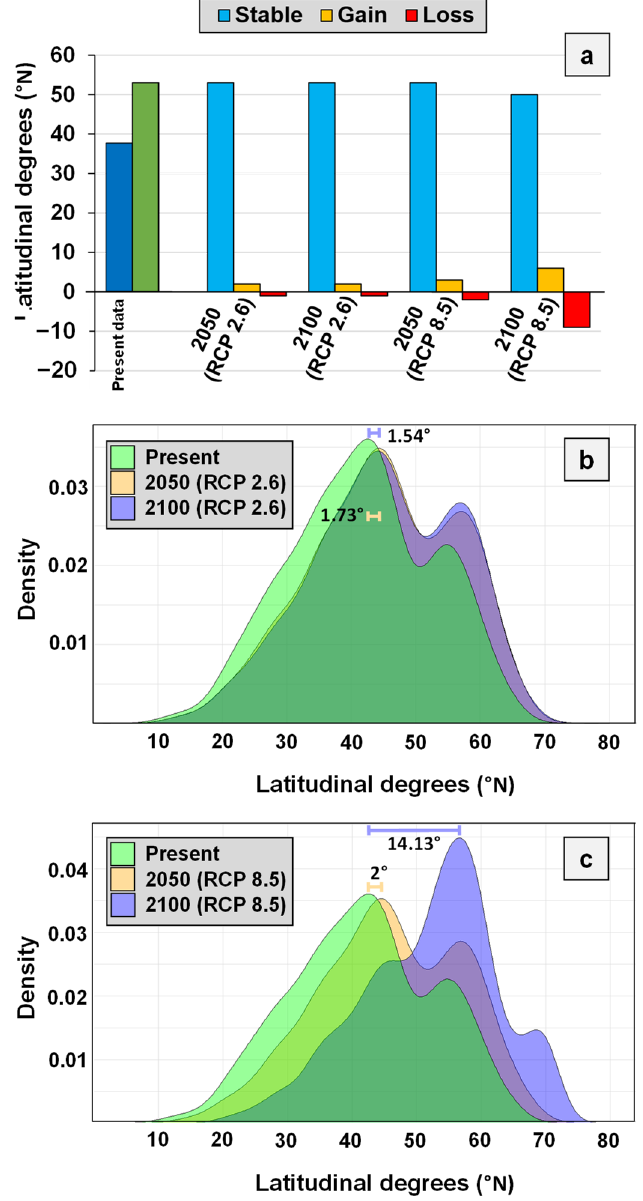
Figure 4. Panel ( a ): Current distribution (green bar), and variations in habitat suitability of Gracilaria vermiculophylla in the Northern Hemisphere under present conditions and under future climate change framework predicted for two carbon emission scenarios (RCP 2.6 and RCP 8.5) by 2050 and 2100. Variations in distribution are expressed in latitudinal degrees (°). Blue colour represents the stable distribution, yellow represents the gain distribution, and red represents the loss habitat distribution. Panel B and C: Probability density curves show more favourable latitudinal (°) regions for habitat colonization of the target species based on sea surface temperature (SST) and surface salinity under both RCP (2.6 (Panel b ) and 8.5 (Panel c )) climate scenarios by 2050 and 2100. Latitudinal changes in the frequency distribution of G. vermiculophylla are shown above each curve for present, future carbon emission scenarios.